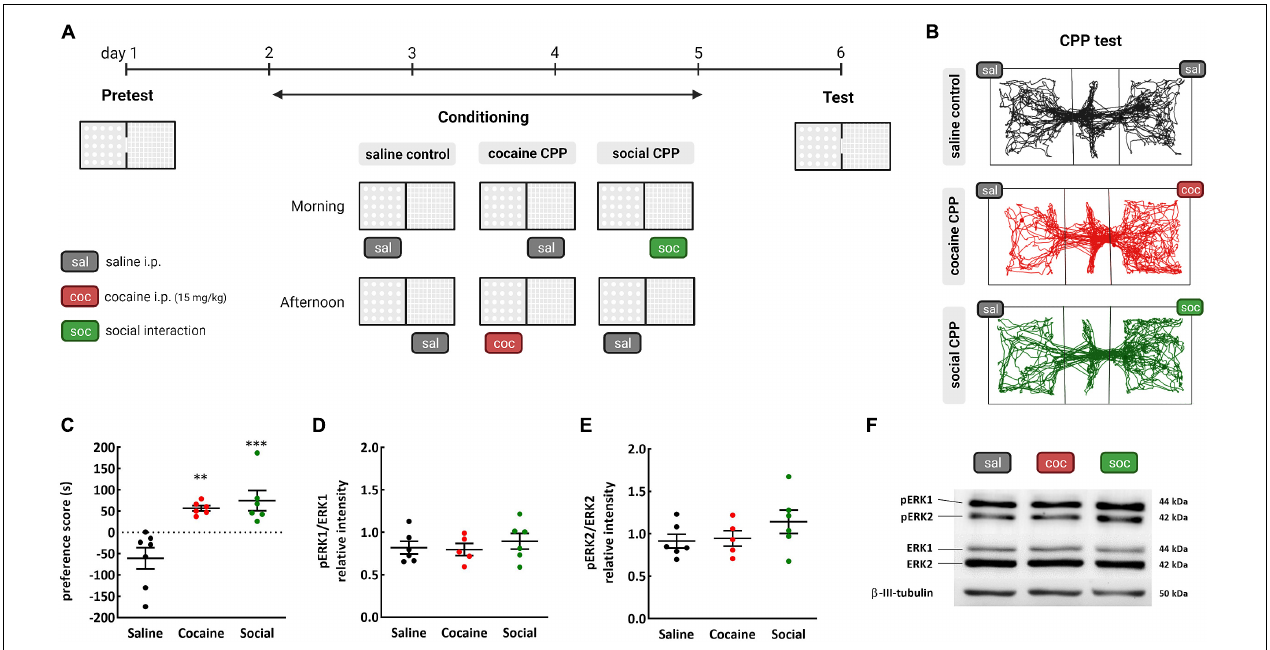
FIGURE 1 | Conditioned place preference (CPP) to cocaine or SI; (A) timeline; (B) representative tracking of rats receiving saline injections in both compartments of the CPP (saline controls), and rats conditioned to cocaine (coc–cocaine CPP) or SI (soc–social CPP) in each compartment during the CPP test; (C) preference score is calculated based on the time the rats spend in the stimulus-associated compartment during the test minus the pretest; (D) pERK 1 and (E) pERK 2 relative intensity of expression in the NAc of rats after the test of CPP to cocaine or SI; (F) representative western blot images of phosphorylated ERK1 and 2, ERK1 and